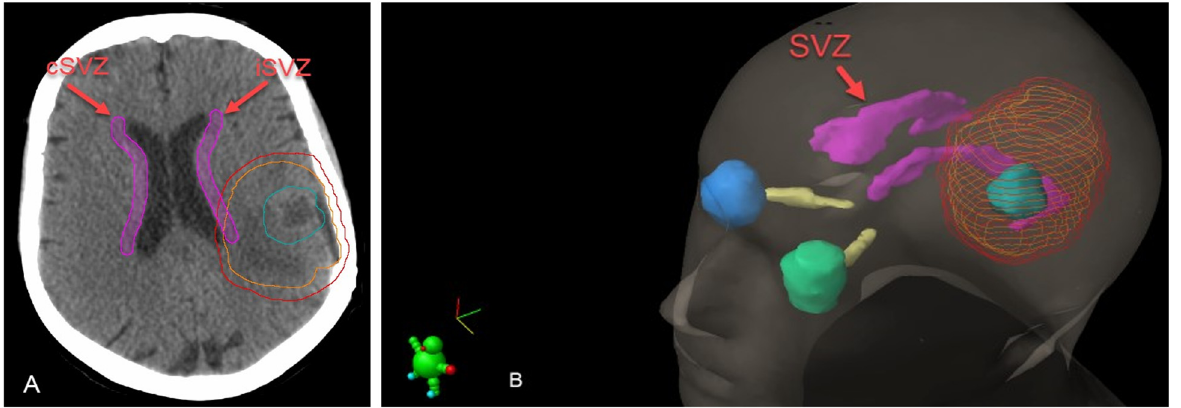
Figure 3. ( A ) Segmentation of SVZ (pink), GTV (blue), CTV (orange) and PTV (red) on the axial CT image. ( B ) Three ‐ dimensional reconstruction of the segmentations. SVZ; subventricular zone. iSVZ; ipsilateral subventricular zone. cSVZ; contralateral subventricular zone.